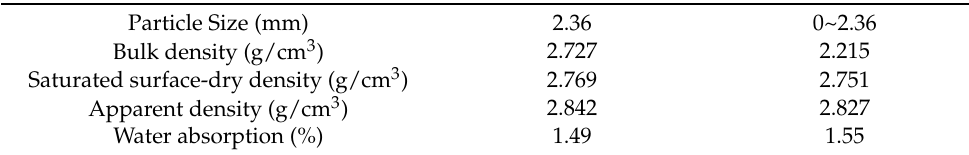
Table 3. Performance parameters of fine aggregate.